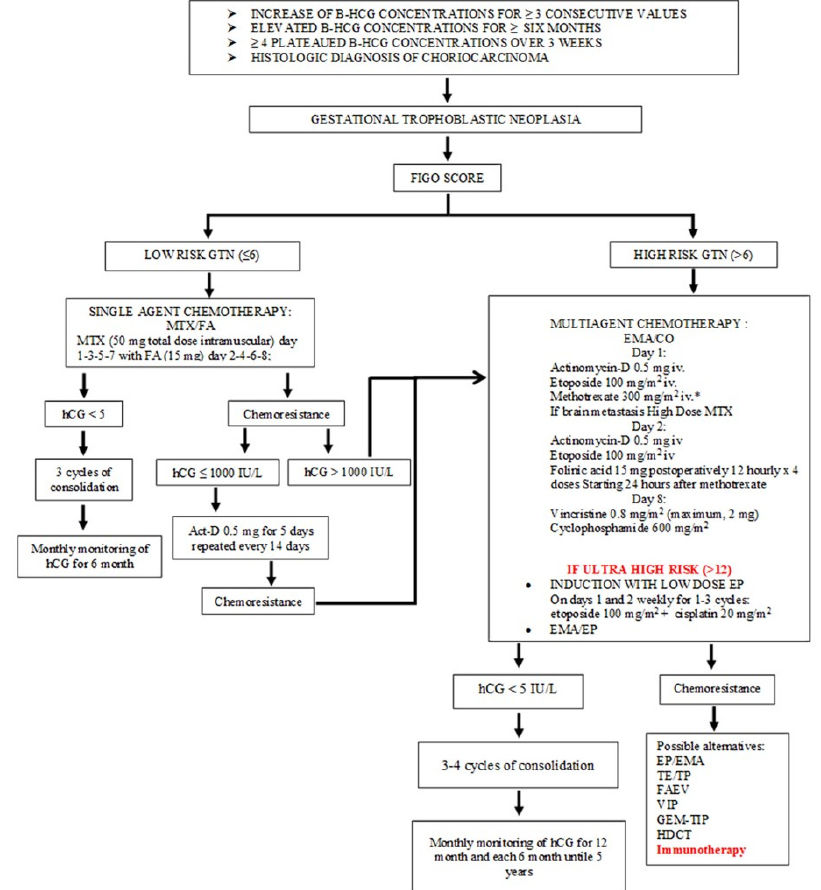
Figure 1. Algorithm for standard treatment of gestational trophoblastic neoplasia (adapted from